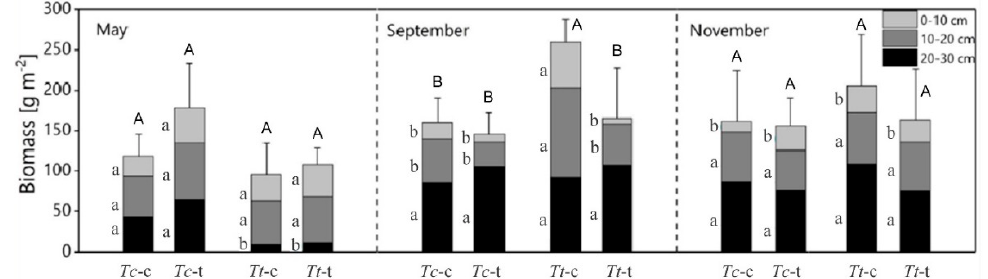
Figure 6. Fine root biomass (g m − 2 ) for the 0–10, 10–20, and 20–30 cm layers of the control and treatment groups of T. cordata and T. tomentosa during May, September, and November 2017. The di ff erent letters indicate significant di ff erences ( p < 0.05) between cultivars and treatments for the overall biomass (capital letters) and di ff erent layers (lowercase